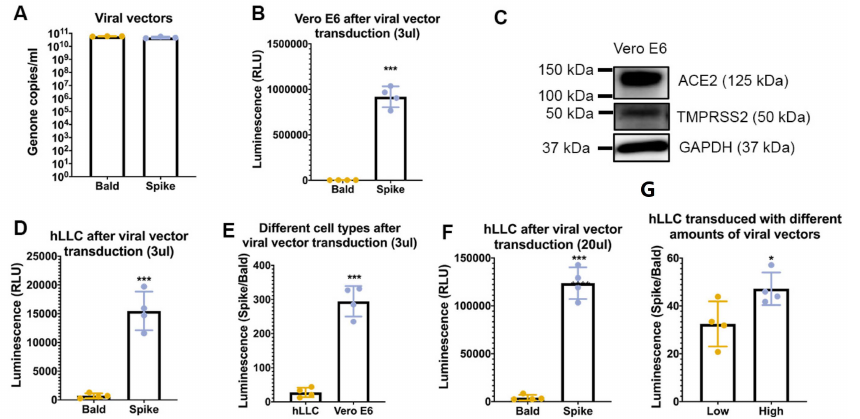
Figure 4. SARS-CoV-2 spike pseudovector can enter ACE2-expressing cells. ( A ) Genome copy number for either SARS-CoV-2 spike protein-containing vector (spike) or vector alone (bald). ( B ) Vero E6 cells were transduced with 3 µ L of either bald or spike. Spike pseudovectors entered Vero E6 cells significantly more than bald vectors. ( C ) Vero E6 cells express ACE2 and TMPRSS2. ( D ) The luminescent signals indicate that spike pseudovectors but not bald vectors could enter hLLCs. ( E ) As the entry capacity of bald vectors in hLLCs and Vero E6 cells were different, we used the luminescent signal ratio of spike pseudovectors to bald vectors to evaluate the susceptibility of cells to spike pseudovectors. According to the luminescent signal ratio, hLLCs are less susceptible to spike pseudovectors than Vero E6 cells. ( F ) The hLLCs transduced with 20 µ L viral vectors display higher luminescent signal of spike pseudovectors to bald vectors. (G) When the amount of SARS-CoV-2 spike pseudovector was increased from low (3 µ L) to high (20 µ L), we detected increased ratio of Spike to Bald luciferase signals in hLLCs. This result suggested that hLLCs are more susceptible to high concentrations of spike pseudovectors. Data are presented as means ± SDs, n ≥ 3. * p < 0.05; *** p <